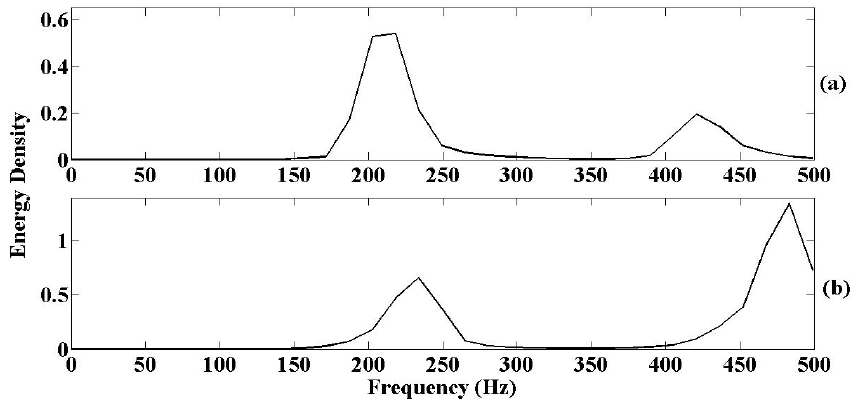
Figure 3. Marginal energy density with respect to frequency for two different voiced regions of the speech signal. Speech signal is taken from the CMU-Arctic database with speaker id